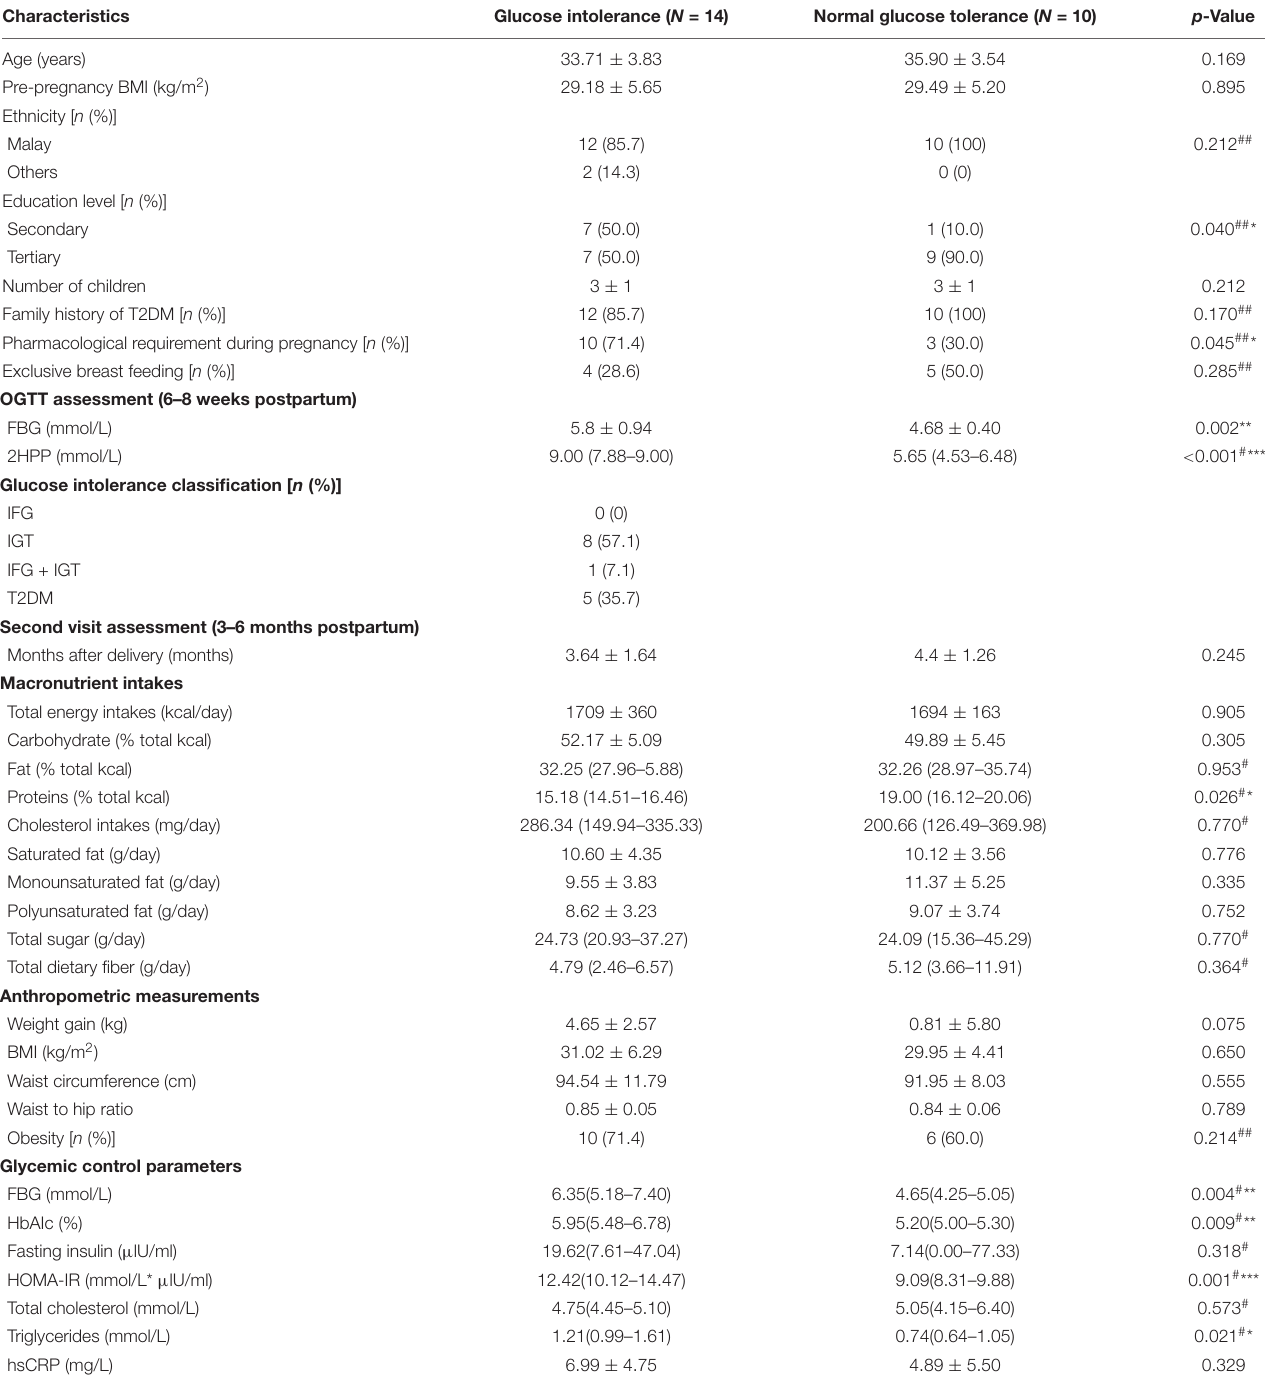
TABLE 1 | Characteristics of post-gestational diabetes mellitus women categorized by postpartum glucose tolerance.